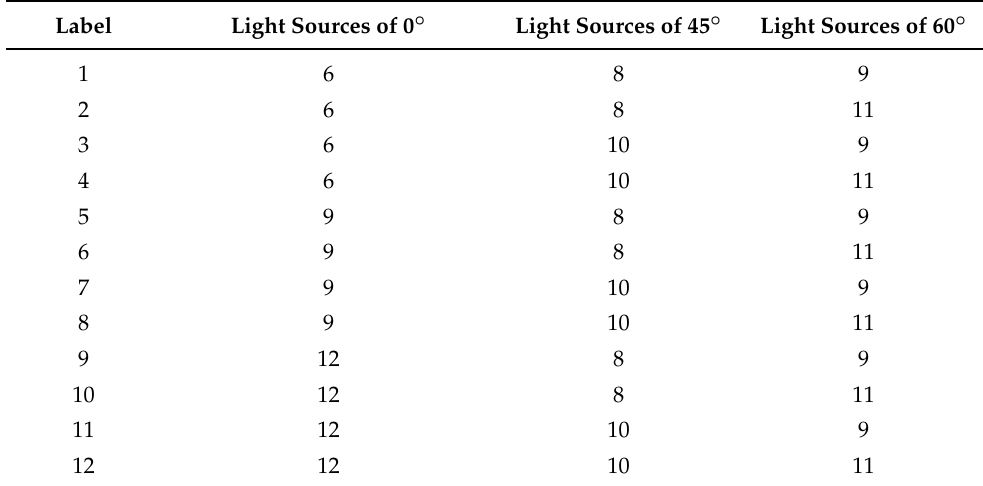
Table 1. Twelve lighting configurations for image